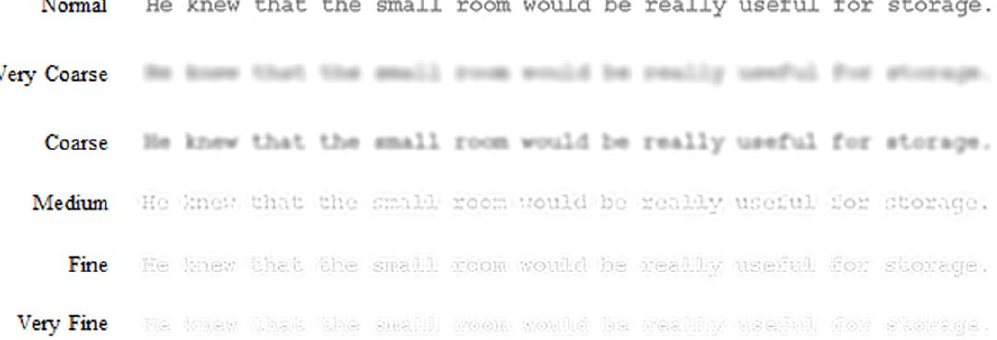
Figure 1. Examples of a sentence displayed as normal and containing only one type of visual content. (a) Very Coarse, (b) Coarse, (c) Medium, (d) Fine, (e) Very Fine. The appearance of each visual content shown in the figure is approximate due to restrictions in resolution and print medium.